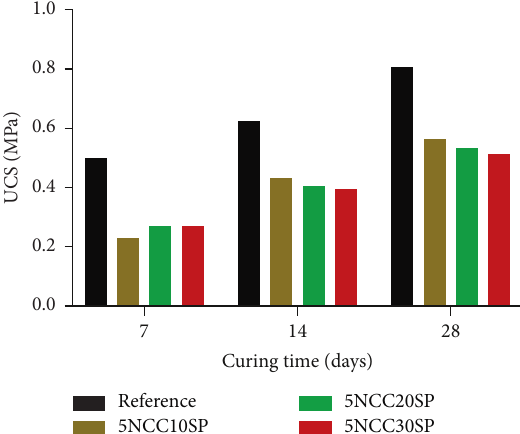
Figure 5: Mean unconfined compressive strength (UCS) for triplicate backfill samples prepared with 5% nano-calcium carbonate (NCC) and 0–30% superplasticizer (SP). See Table 5, for mixture